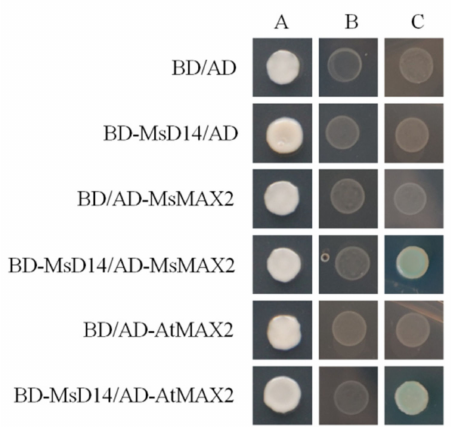
Figure 5. The interaction between MsD14 with MsMAX2 and AtMAX2. ( A – C ) SD/-L/-W, SD-L/- W/-H/-A+X-A-gal, and SD-L/-W/-H/-A+X-a-gal+GR24,